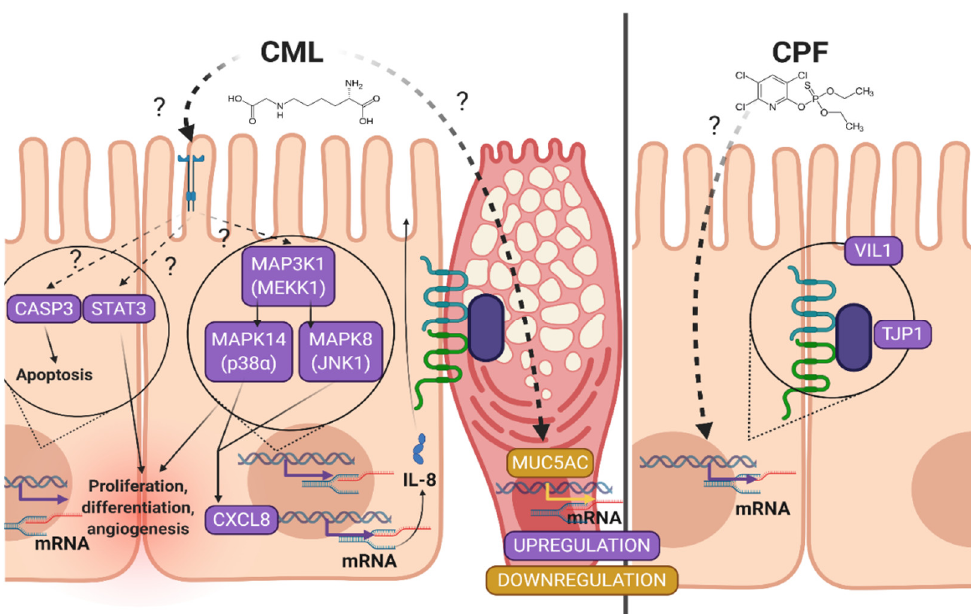
Figure 7. Potential effects of food contaminants on the co-culture of Caco-2/TC7 and HT29-MTX after a 6 h stimulation. CASP3 , Caspase 3; CASP9 , Caspase 9; CLDN4 , Claudin 4; CML, N(6)-Carboxymethyllysine; CPF, Chlorpyrifos; CTL, control; CXCL8 , Interleukin 8; MAP3K1 , mitogen-activated protein kinase 1; MAPK8 , mitogen-activated protein kinase 8; MAPK14 , mitogen-activated protein kinase 14, also called p38- α ; MUC3 , Mucin 3; MUC5AC , Mucin 5AC; MyD88 , myeloid differentiation primary response gene 88; NF- κ B , nuclear factor-kappa B; OCLN , Occludin; STAT3 , signal transducer and activator of transcription 3; TJP1 , tight junction protein 1; TNF- α , tumor necrosis factor α ; VIL1 , Villin 1.